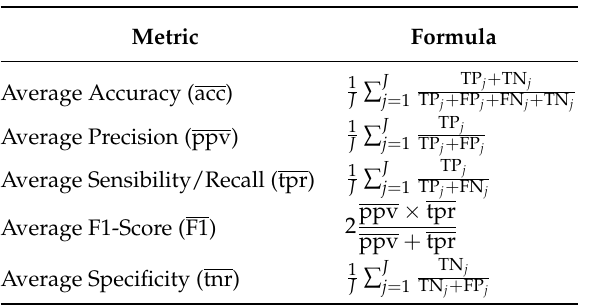
Table 3. Metrics for evaluating multi-class classification models, where j refers to the individual class and J is the total number of classes.